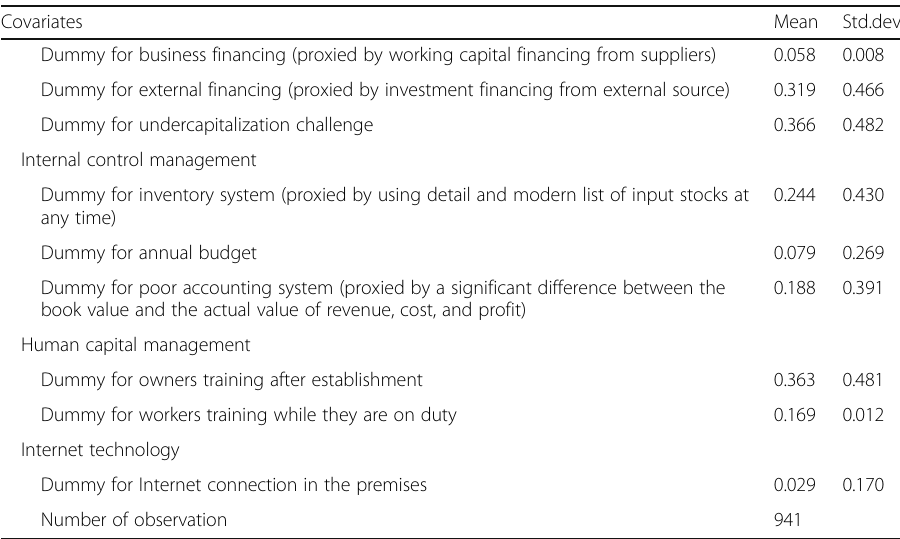
Table 1 Definition of variables and their corresponding mean and standard deviation value